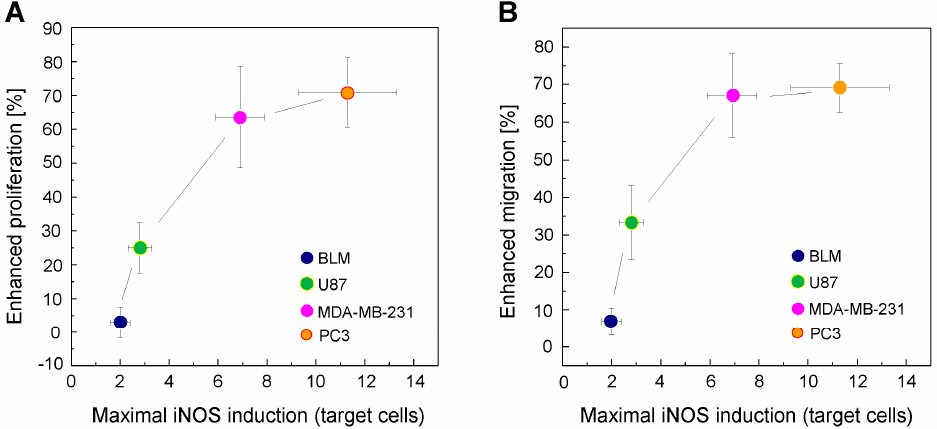
Figure 7. Increased proliferation and migration of BLM, MDA-MB-231, U87, and PC3 bystander cells as a function of maximal iNOS induction in targeted counterparts. ( A ) Elevated proliferative potency vs. greatest extent of targeted iNOS upregulation for the di ff erent cell lines. ( B ) Elevated migratory potency vs. greatest extent of targeted iNOS upregulation for the di ff erent lines. Data points for proliferation or migration are means ± SEM ( n = 5–6) and those for iNOS are means ± SEM ( n = 3).